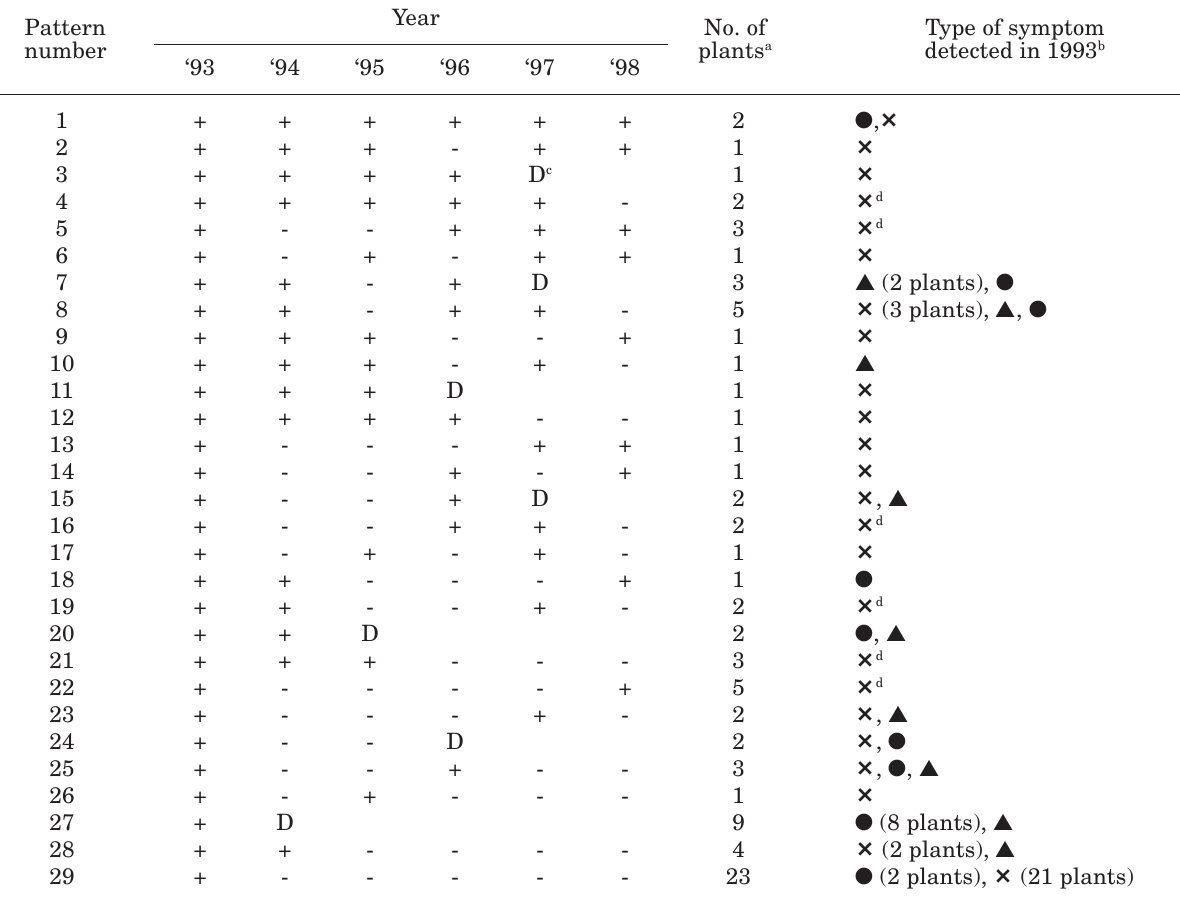
Table 5. External symptom expression from 1994 to 1998 in vines that had been symptomatic in the first year (1993) of the survey at Gambassi Terme